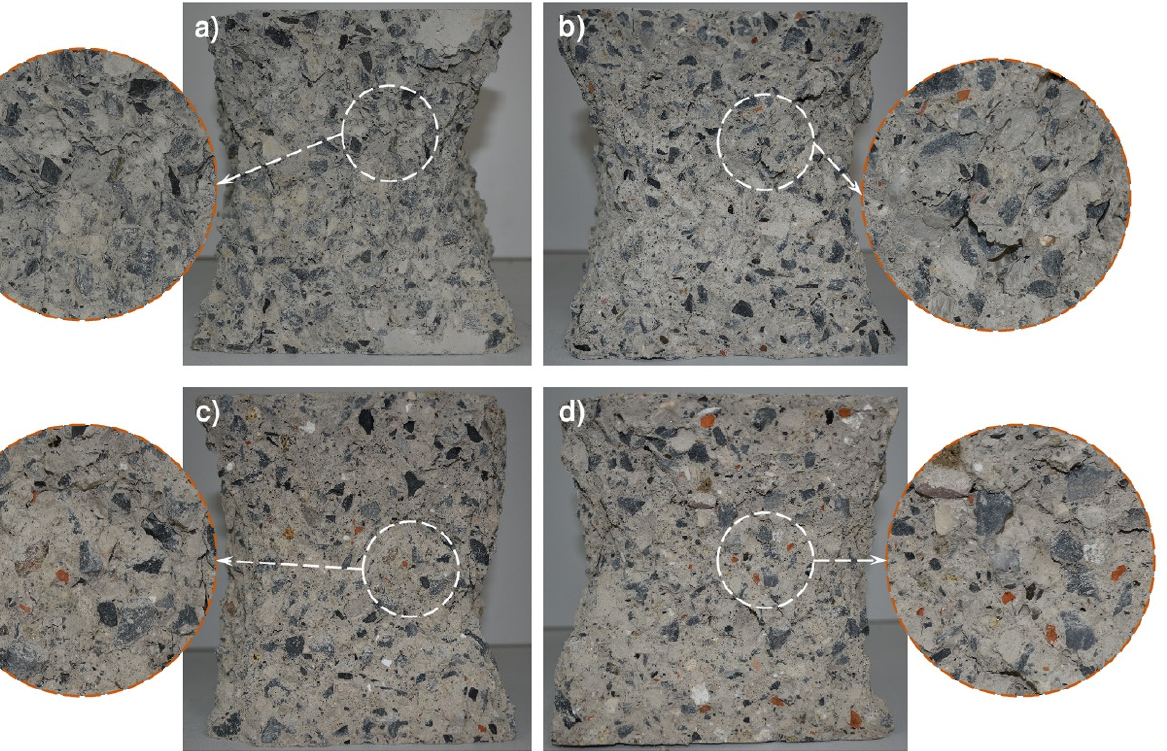
Figure 7. Type of failure of the concretes: ( a ) M1; ( b ) M3; (c) M6; and ( d ) M9.